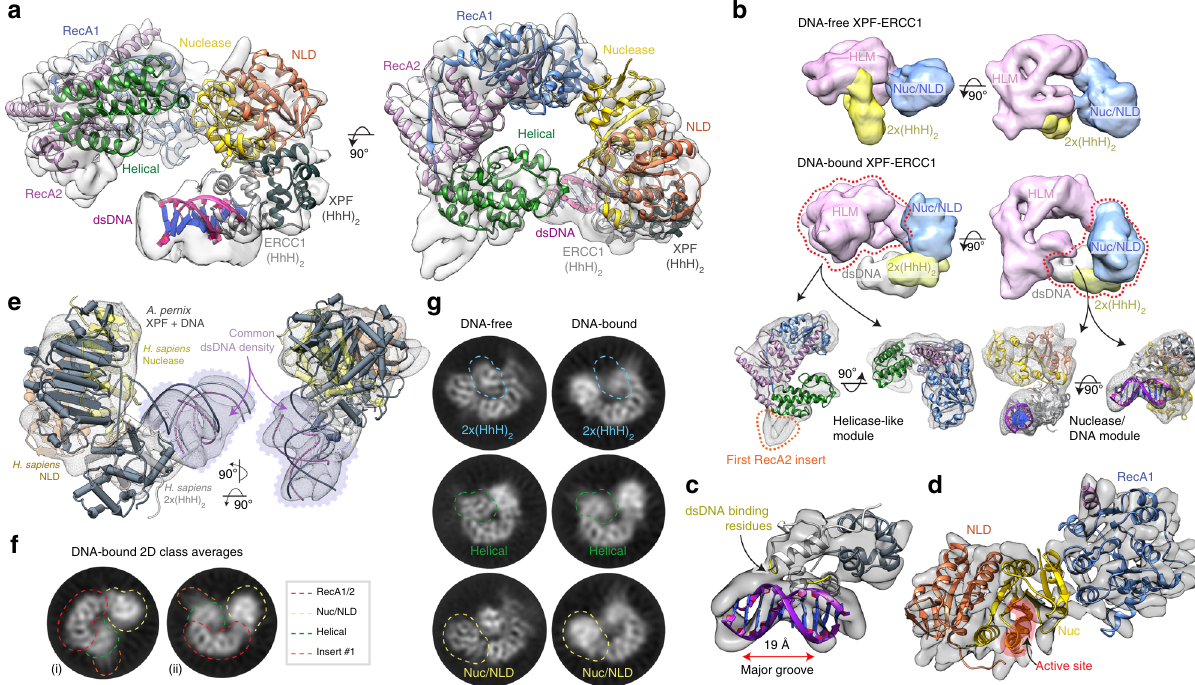
Fig. 4 Conformational reorganisation of XPF – ERCC1 engaged by a DNA-junction substrate. a Two orthogonal views of DNA-bound XPF – ERCC1 ribbon structure coloured by domain according to Fig. 1a. The dsDNA duplex is shown in purple. The ribbon model is shown with the cryo-EM composite map, ranging from 5.9 – 7.7 Å global resolution. b Top and middle: two orthogonal views comparing segmented DNA-free and DNA-bound maps. The DNA- bound map displayed is the globally re fi ned and unsharpened 7.7 Å map. The DNA-free map displayed is the globally re fi ned and unsharpened 4.0 Å map low-pass fi ltered to 9 Å resolution to display comparable levels of detail to the DNA-bound map. Both maps were segmented in UCSF Chimera revealing sub-volumes for the XPF HLM (pink), XPF nuclease – ERCC1 NLD dimer (blue), 2×(HhH) 2 domain (yellow) and dsDNA (white). Bottom: two orthogonal views of the HLM and the CM/ERCC1 dsDNA-binding module. Each sub-volume contains the ribbon model of DNA-bound XPF – ERCC1, orange dotted line indicates unmodeled density corresponding to the position of the fi rst RecA2 domain fl exible insert. c Fitted model for the dimeric 2×(HhH) 2 domain engaging dsDNA via the minor groove, placed within map density. Major groove distance and dsDNA-binding residues are indicated. The dsDNA-binding hairpin residues of ERCC1 are highlighted in yellow. d Model for the XPF RecA1 – nuclease/ERCC1 NLD interface following substrate engagement. Labels and red circles indicate the XPF active site location. e Human XPF nuclease – ERCC1 NLD dimer, 2×(HhH) 2 domain and dsDNA positioned within the cryo-EM map together with a structurally superposed A. pernix XPF structure (PDB code 2BGW) bound to dsDNA. A similar dsDNA trajectory is evident (purple box). f 2D class averages of DNA-bound XPF – ERCC1 with coloured dotted lines indicating the position of domains according to the key. g Comparison of 2D classes of the same molecular views from DNA-free (left column) and DNA-bound (right column) XPF – ERCC1 with coloured circles indicating the position of key domains, coloured according to panel ( f